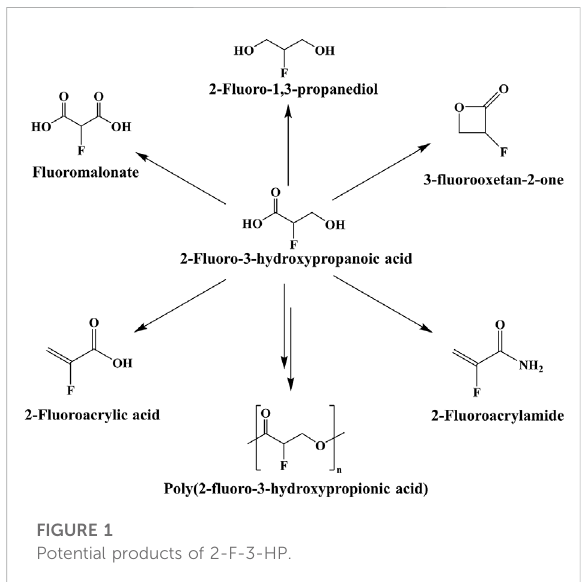
FIGURE 1 Potential products of